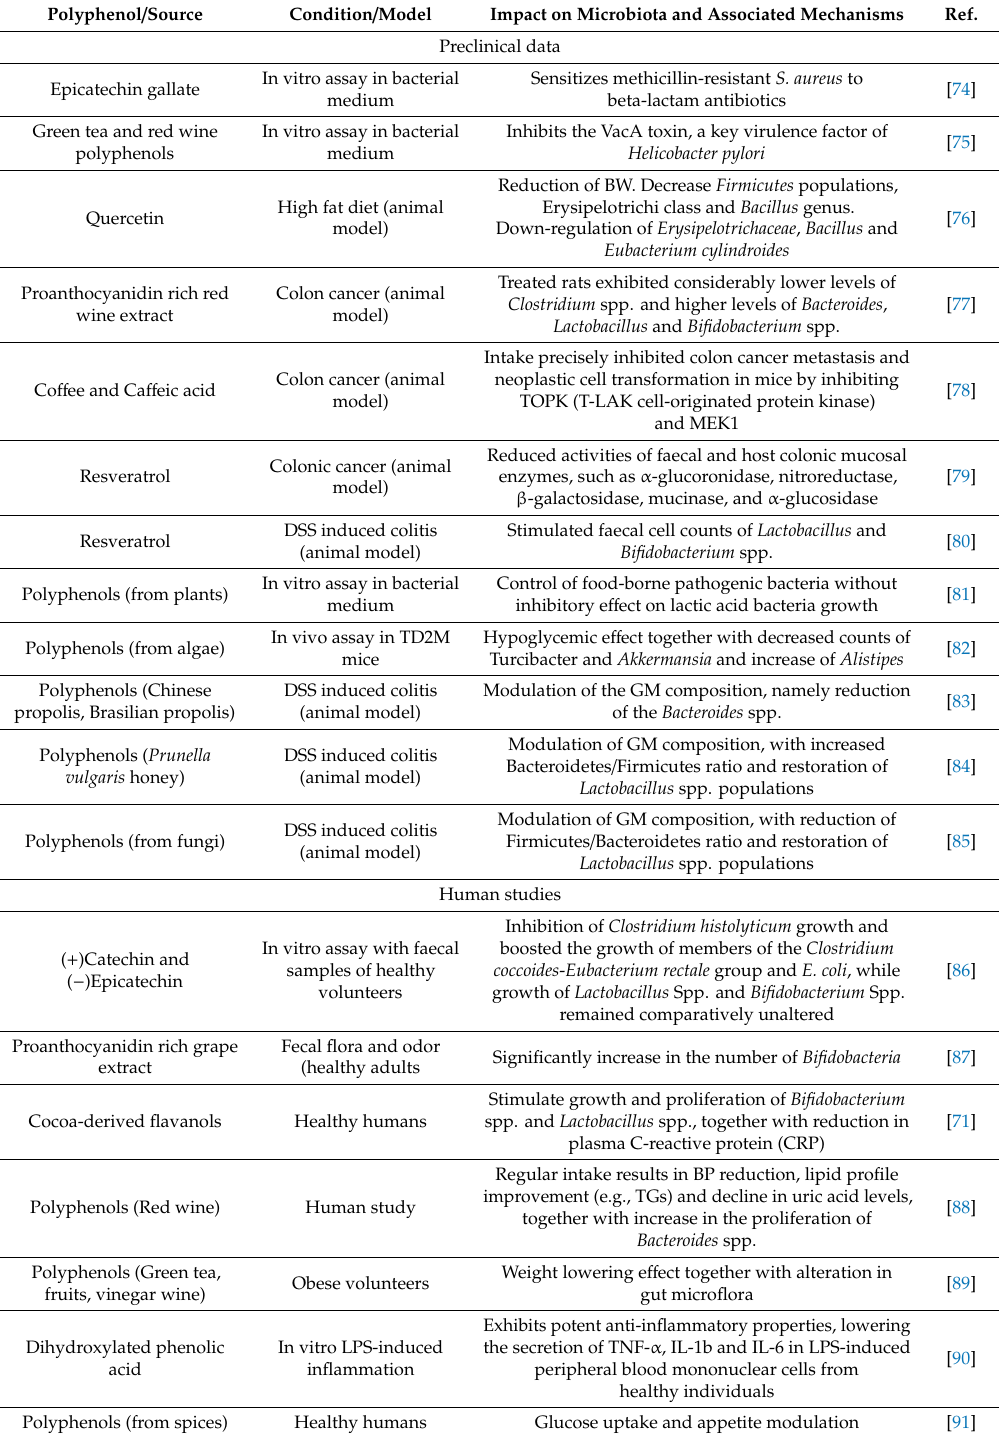
Table 1. Main preclinical and human data reporting the e ff ects of polyphenols on gut microbiota and associated